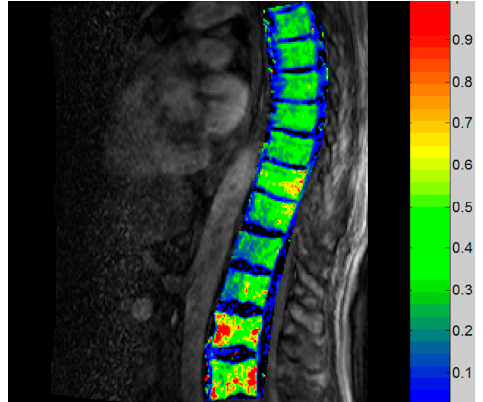
Figure 3. Example of K trans map. The figure represents the K trans map of Pt 1 at T0. The different colors correspond to K trans values in min − 1 , as shown in the right.